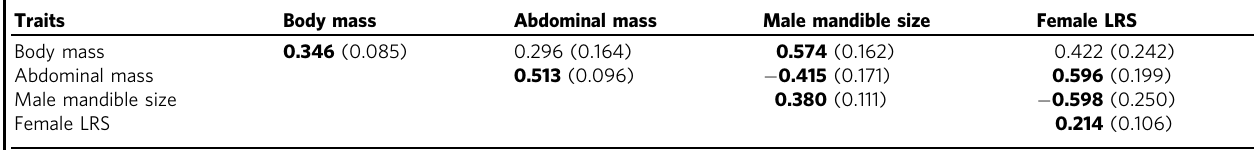
Estimates are shown standardized to narrow sense heritability ( h 2 ; bolded diagonal) and genetic correlations ( r G ; above diagonal). Values were estimated using a four-trait animal model with body and abdomen mass treated as the same trait in both sexes (but with sex as a fi xed effect). Standard errors are denoted in parentheses and bold font denotes estimates that are nominally signi fi cant at P < 0.05 assuming approximate 95% CI are provided by the estimate ±1.96